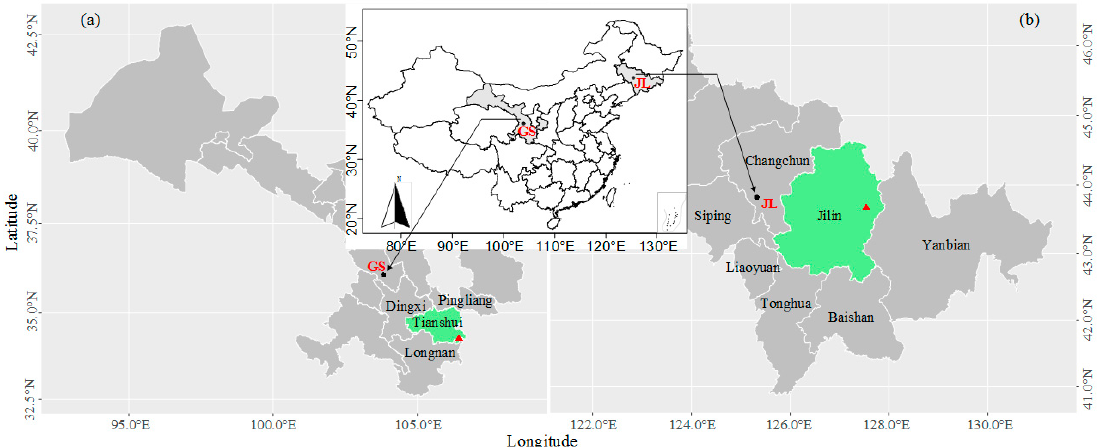
forest is located in Southeast Tianshui City in Gansu Province (GS), and that of ( b ) Pinus koraiensis Sieb. et Zucc. broad-leaved mixed forest is located in Eastern Jilin City in Jilin Province (JL),